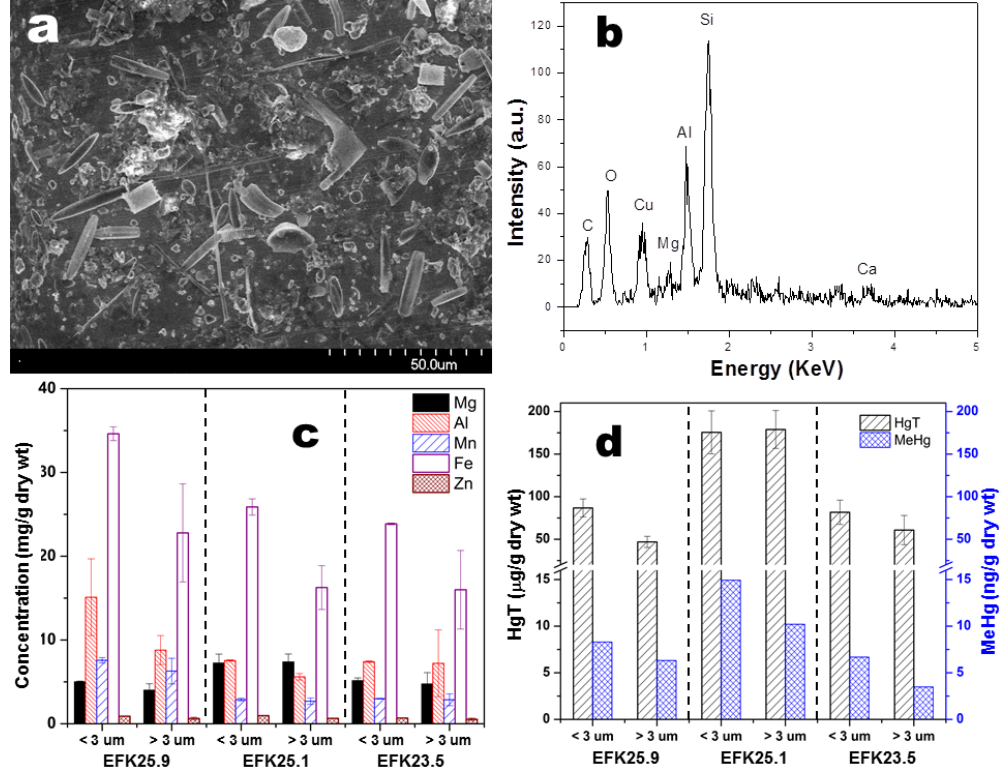
Figure 1. (a) SEM image of suspended particulates containing both diatoms and mineral particles from EFPC in Oak Ridge, Tennessee; (b) energy dispersive X-ray (EDX) analysis of particulates in (a) , showing the dominant elemental composition of Si, Al, O, and C (note: the Cu signal is from the use of copper grid sample holders); (c) bulk analysis of major cations on EFPC particles collected from three locations (EFK25.9, EFK25.1, and EFK23.5) and two size fractions by ICP-MS following digestion in 1:1 concentrated HCl:HNO 3 ; (d) distribution of total Hg (HgT) and MeHg associated with EFPC particles of two different size